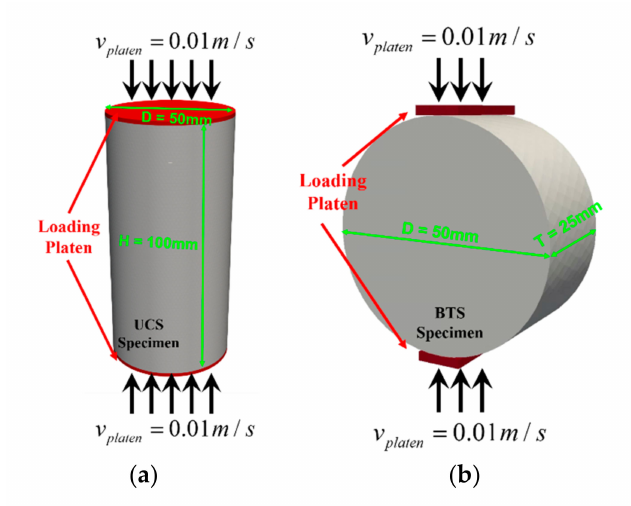
Figure 4. FDEM simulation models used for calibrating the input parameter in combined FEM